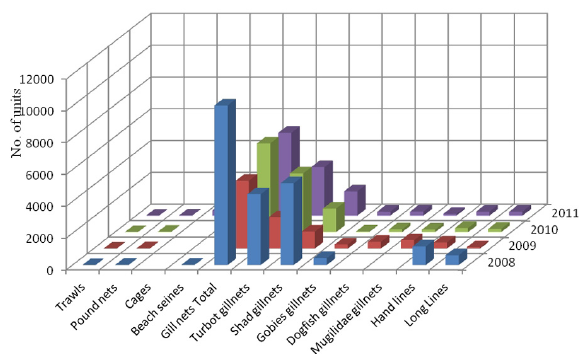
Fig. 3. – Number of units per fishing gear (National Reports 2008-2012/BSC).